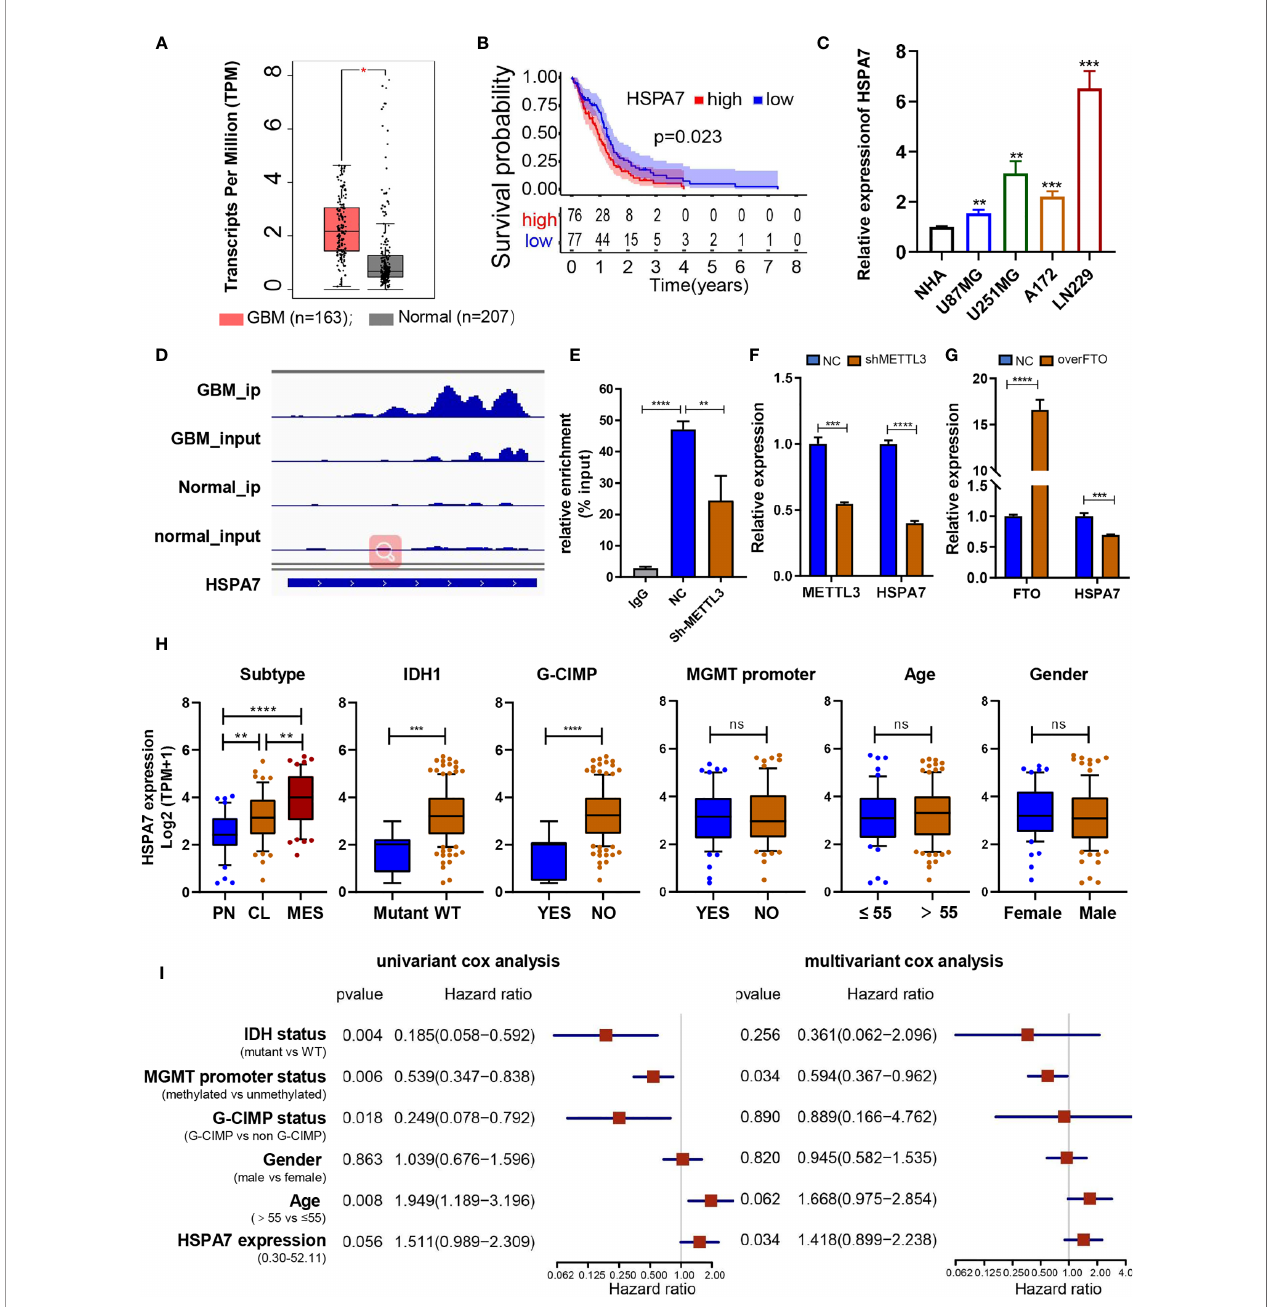
FIGURE 2 | Identi fi cation of the immune-stromal-m 6 A-related pseudogene HSPA7 as a novel prognostic factor in GBM. (A) The GEPIA database showed that HSAP7 was overexpressed signi fi cantly in GBM tissues compared with GETx normal brain tissues. (B) Kaplan – Meier survival curves show that HSPA7 is a prognostic risk factor in GBM. (C) qPCR assays showing that HSPA7 expression was signi fi cantly higher in GBM cells than in NHA cells. Data are presented as the mean ± SD, n = 3. Means were compared with one-way ANOVA, and the NC group is indicated as the control. (D) The gene IGV plots of HSPA7 in the m 6 A-seq. (E) MeRIP assay showing that HSPA7 was highly enriched by the m 6 A antibody, and the modi fi cation can be regulated by the m 6 A methyltransferase METTL3. Data represent mean ± S.D. from three independent experiments. qPCR assay showing that the expression of HSPA7 can be regulated by (F) m 6 A methyltransferase METTL3 and (G) demethylase FTO. Data represent mean ± S.D. from three independent experiments. (H) Distribution of HSPA7 expression in different cohorts strati fi ed by molecular subtype (CL, n = 56; MES, n = 51; PN, n = 44; PN vs MES, P < 0.0001; CL vs MES, P = 0.0020; PN vs CL, P = 0.0013), IDH1 status (mutant, n = 8; WT, n = 141; P = 0.0002), G-CIMP status (G-CIMP, n = 9; non-G-CIMP, n = 142; P < 0.0001), MGMT promoter status (methylated, n = 55; unmethylated, n = 67; P = 0.7445), age (high, age > 55, n = 100; low, age ≤ 55, n = 53; P = 0.5114), and sex (female, n = 54; male, n = 99; P = 0.3996).